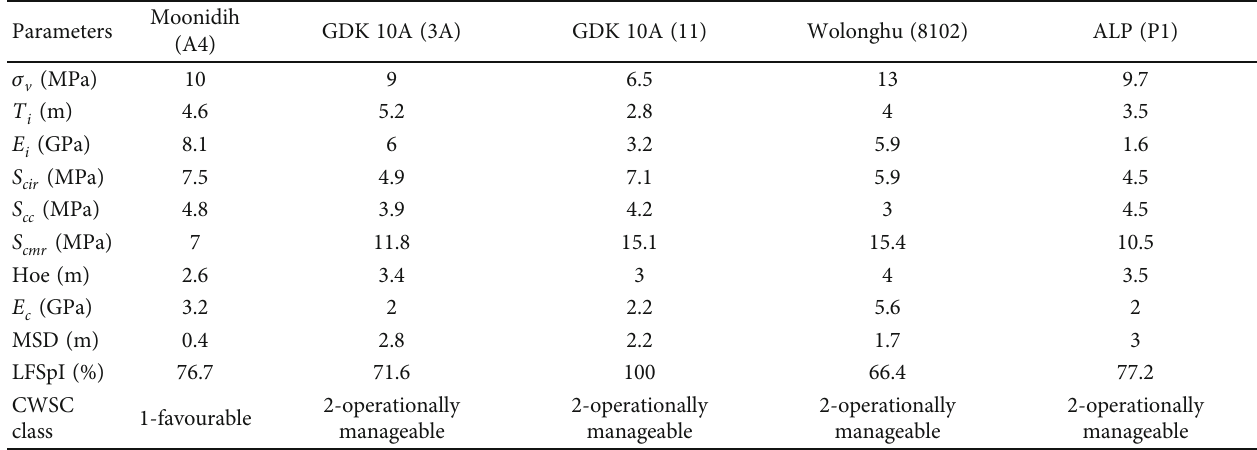
Table 8: Applications of the CWSC